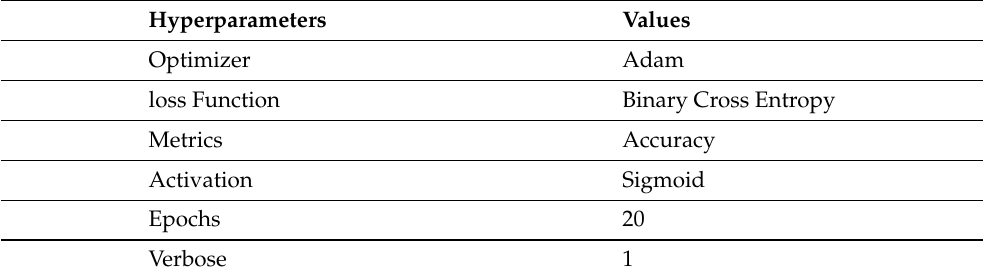
Table 7. The best-fit hyperparameter tuning analysis of all employed neural network